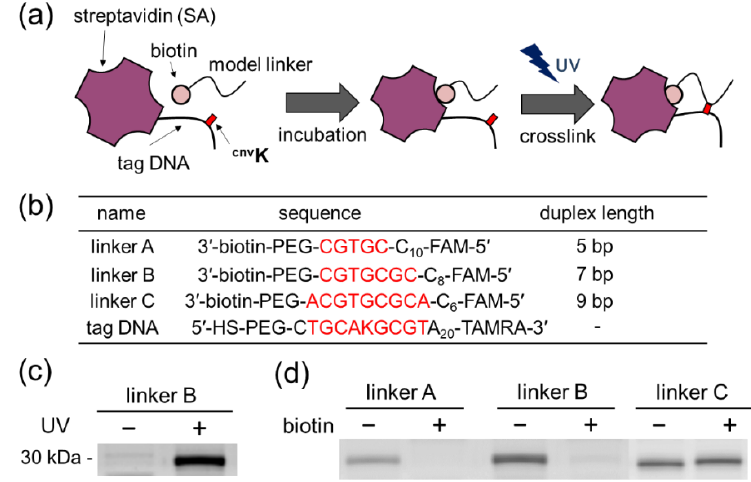
Figure 2. Ligand-dependent photocrosslinking of linker DNA to a model protein. ( a ) Schematic representation of the experiment. A tag DNA containing cnv K was chemically conjugated to streptavidin (SA), and irradiation was performed after incubation with a biotin-labeled model linker DNA with or without a competitor ligand (free biotin). ( b ) Oligonucleotides used in this experiment. carboxyfluorescein (FAM) and tetramethylrhodamine carboxylic acid (TAMRA) are fluorescent molecules for detection. SH stands for thiol, and hybridized bases are marked in red. PEG indicates a polyethylene glycol (PEG) spacer 18. ( c ) Confirmation of photocrosslinking. SA-tagged DNA and a linker (duplex length = 7-mer) were mixed, and UV irradiation was performed before SDS-PAGE. The gel image was taken using a fluorescence imager with a FAM filter set. ( d ) Inhibition of crosslinking by free biotin. All samples were irradiated with UV light before analysis.